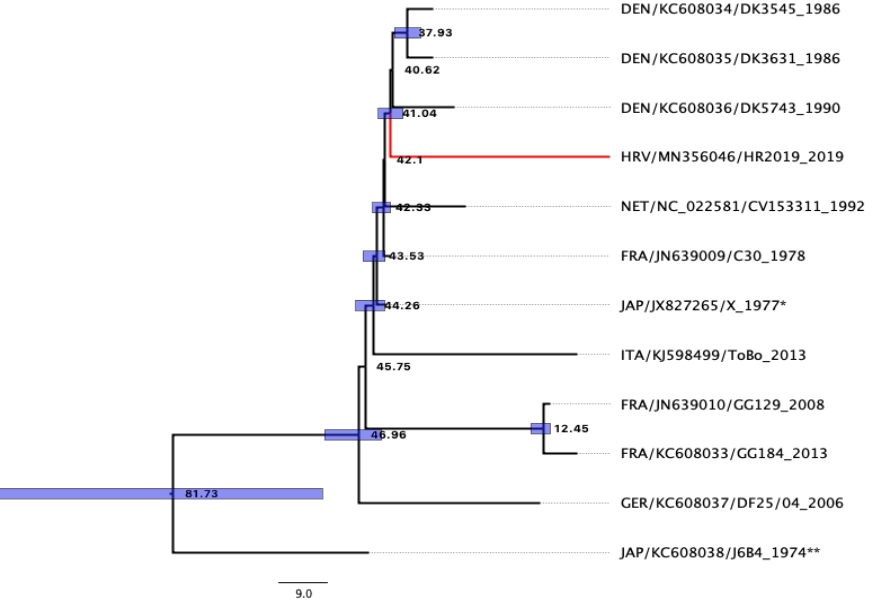
Figure 4. The most common ancestor (MCA) phylogenetic tree of the EVEX isolate based on the studied genes (N, P, C, M and G), constructed using Bayesian phylogenetic analysis. The numbers on the tree are equal to years. Blue boxes mark credibility interval with probability PP > 0.95.